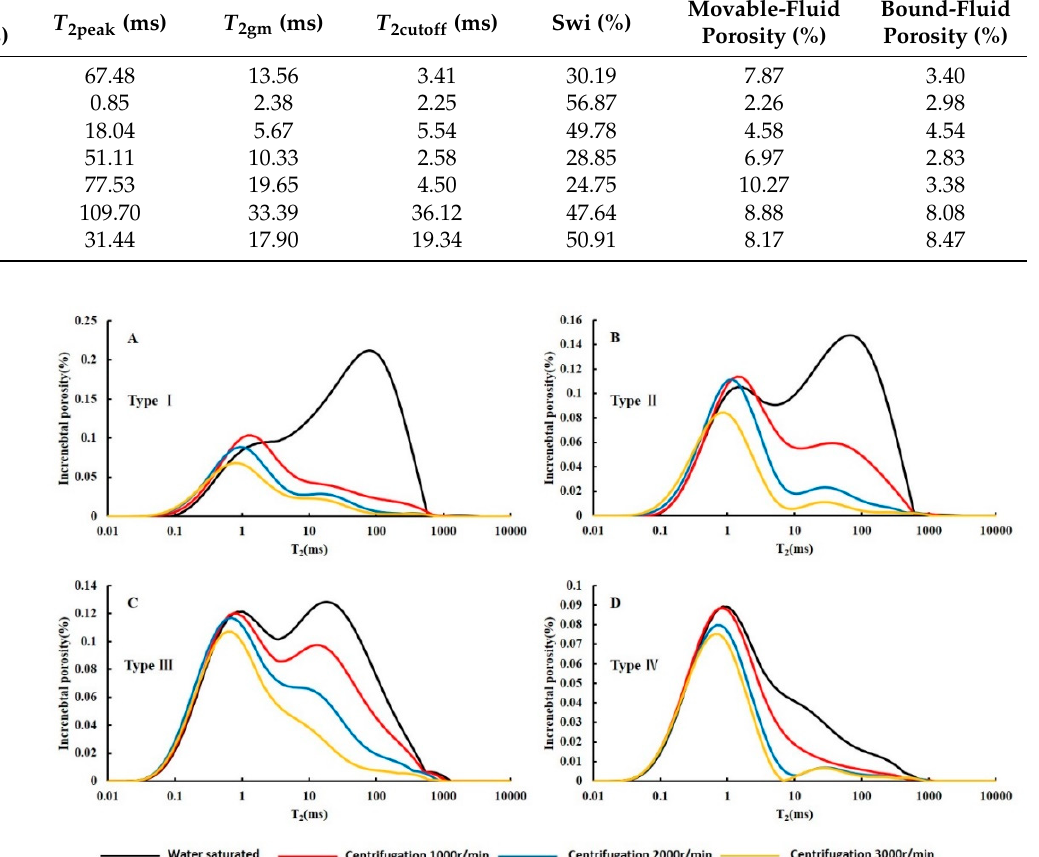
Figure 8. NMR T 2 incremental spectrums for water saturated and centrifugation with different speeds. ( A ) Sample 5; ( B ) Sample 1; ( C ) Sample 3; ( D ) Sample 2.